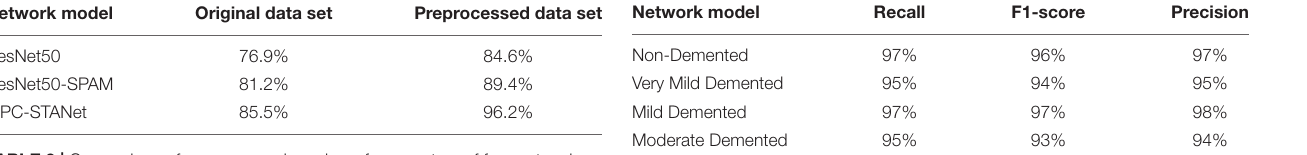
TABLE 3 | Comparison of accuracy and number of parameters of four networks.